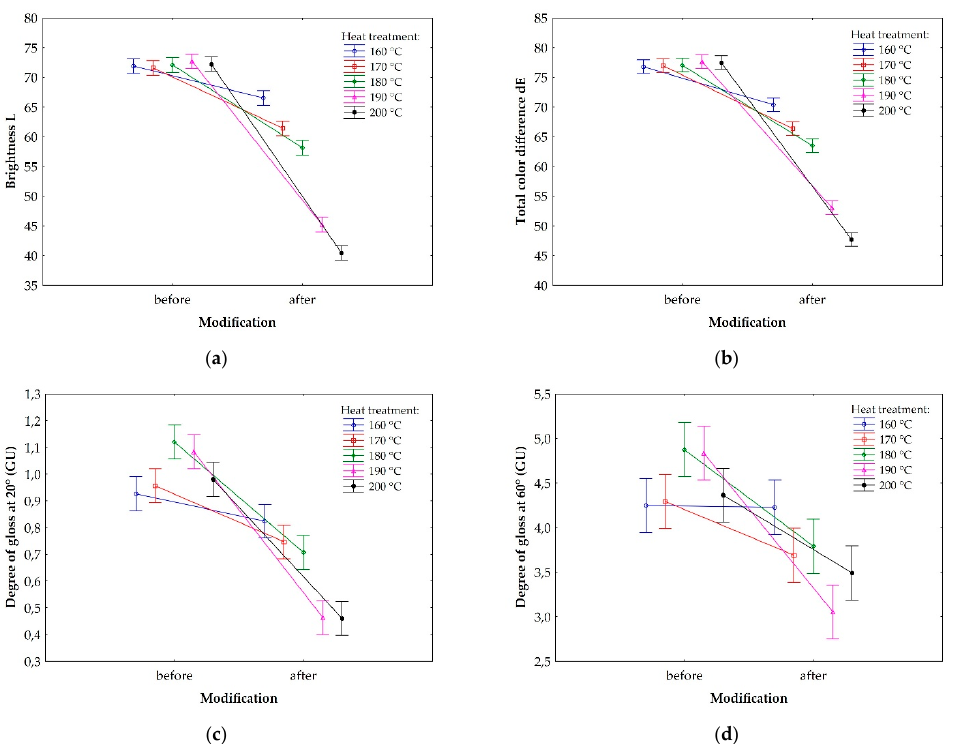
Figure 13. Graphic visualization of the effect of heat treatment temperature on ( a ) brightness, ( b ) total colour difference, ( c ) degree of gloss at 20°, and ( d ) degree of gloss at 60°. Significance level is at a 95%.